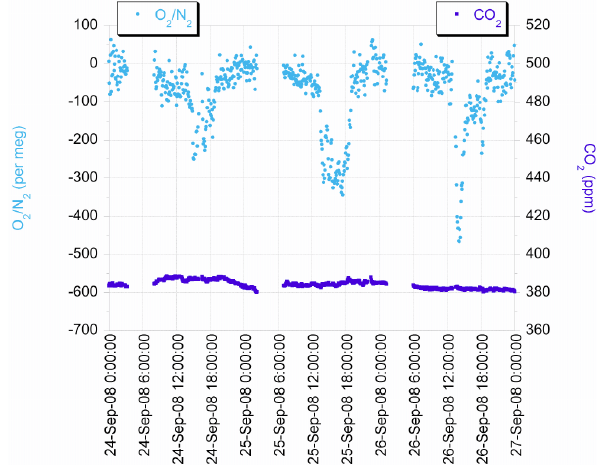
Fig. 8. Observations at the F3 platform for δ O 2 /N 2 (lighter circles) and CO 2 (darker squares) during 24 through 26 September